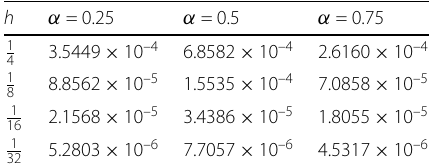
Table 6 Maximum absolutes ( L ∞ ) for Example 1 at t = 1 with (cid:3) t = h 2 and z ∈